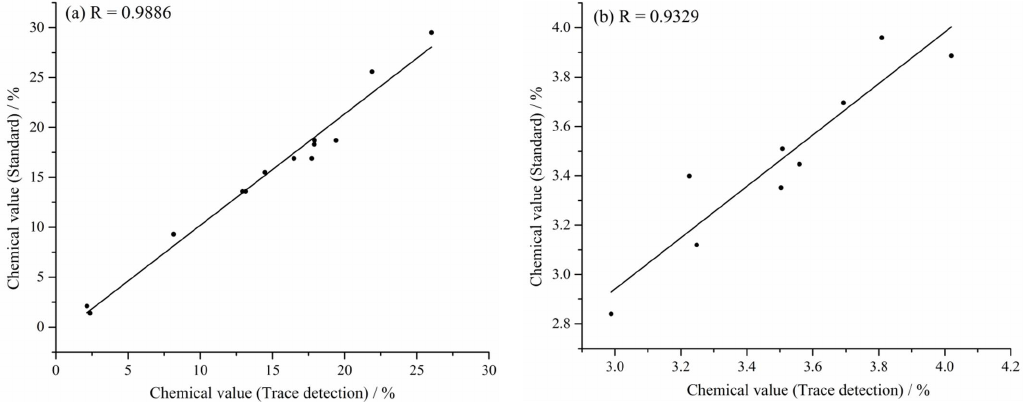
Figure 3. Scatter plots of rice AC ( a ) determined using the two iodine colorimetric methods and rice FC ( b ) determined using the two Soxhlet extraction methods.